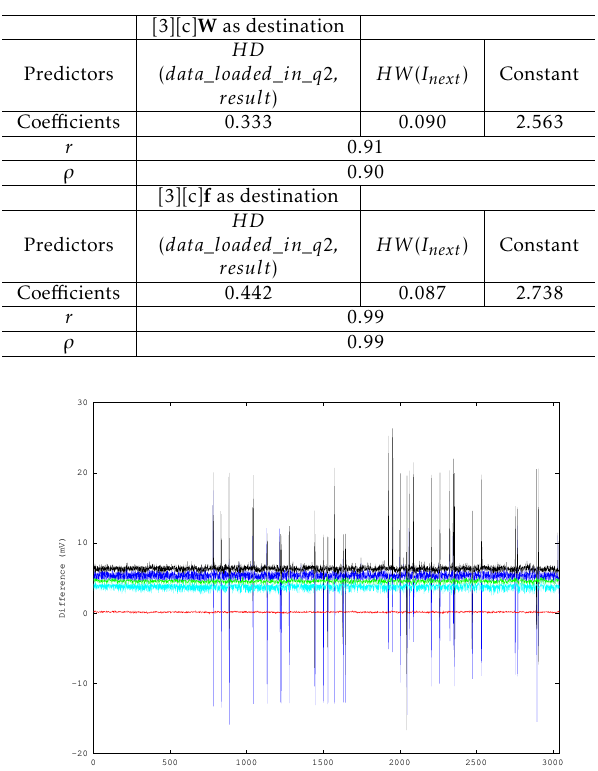
Table 5. Regression analysis of EM radiation in Q4